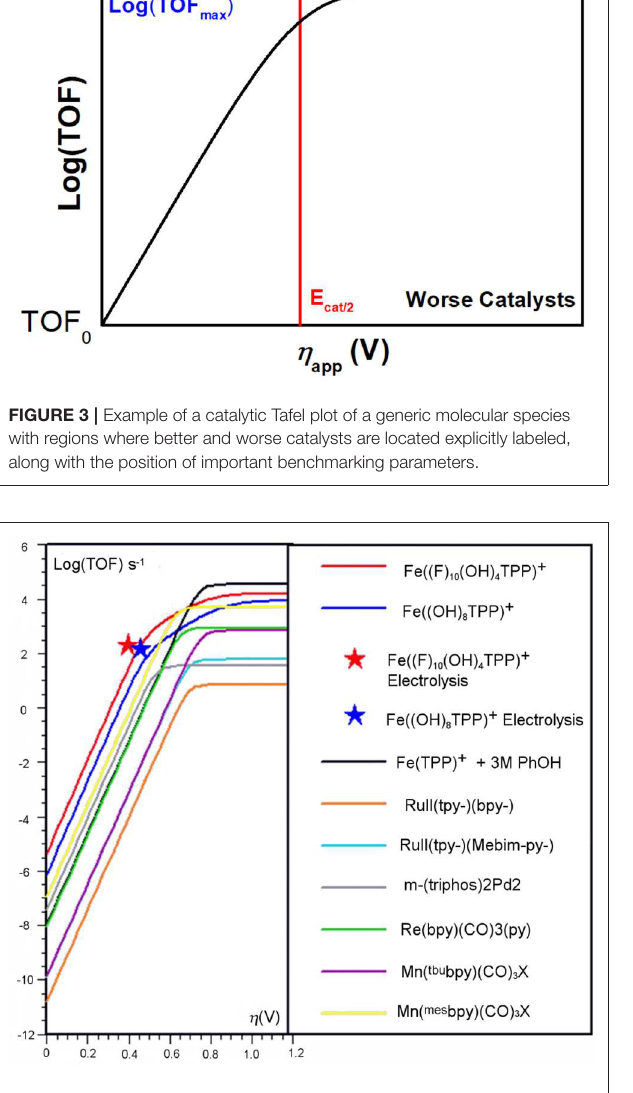
FIGURE 4 | Catalytic Tafel plot showing enhancements from the inclusion of a secondary coordination sphere in the [Fe(TPP)] + system (Costentin et al.,